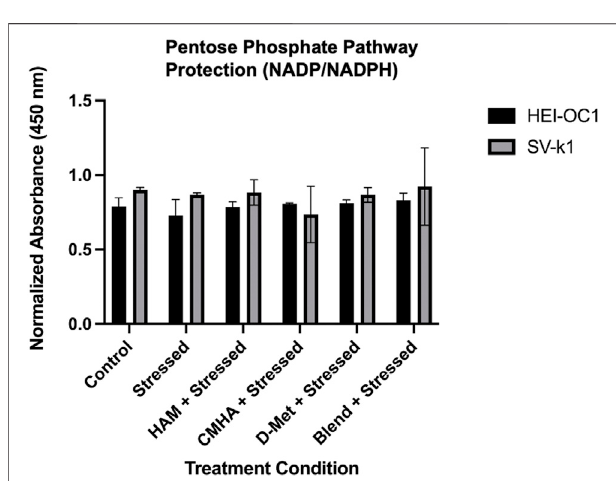
FIGURE7| Investigation ofthepotentialmechanism ofHAM protection. Data presented are mean ± SD. One-way ANOVA with Tukey ’ s multiple comparisons run for each cell type individually. HEI-OC1 ANOVA versus unstressed control: stressed p = 0.7694, HAM p > 0.9999, CMHA p = 0.9989, D-Met p = 0.9964, and blend p = 0.9391. SV-k1 ANOVA versus unstressedcontrol:stressed p =0.9996,HAM p > 0.9999,CMHA p =0.6927, D-Met p = 0.9997, and blend p >